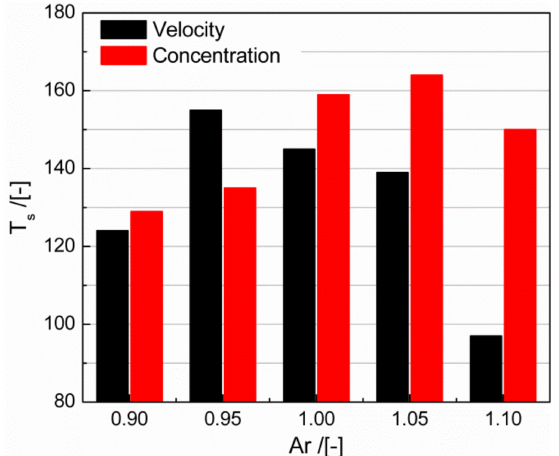
Figure 13. Onset time of oscillations of velocity and concentration with different aspect ratios ( Ca C = − 0.01, R = 2.5 mm, H/R = 0.9, 0.95, 1.0, 1.05 and 1.1, Vr =